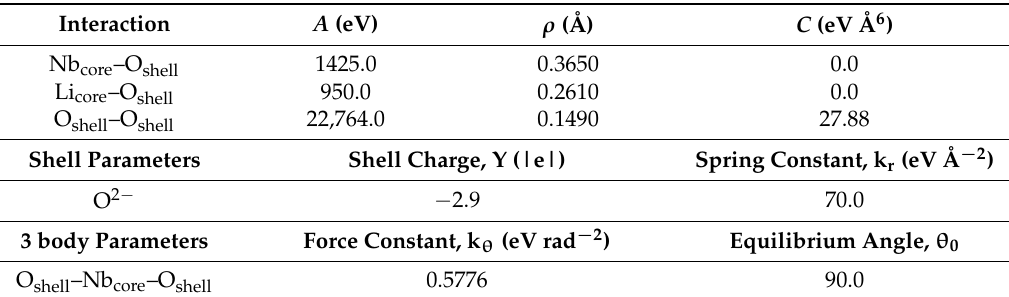
Table 1. Potential parameters for LiNbO 3 [7].